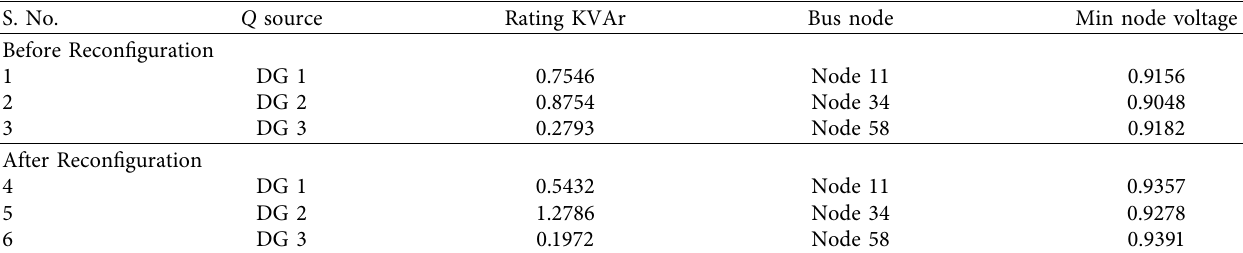
Table 9: Results of Q power injected to the real time system.